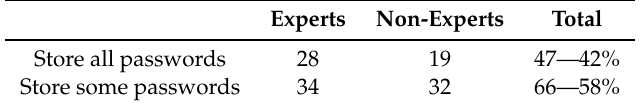
Table 23. 62 Experts and 51 Non-experts (113 users) who store all or some passwords.